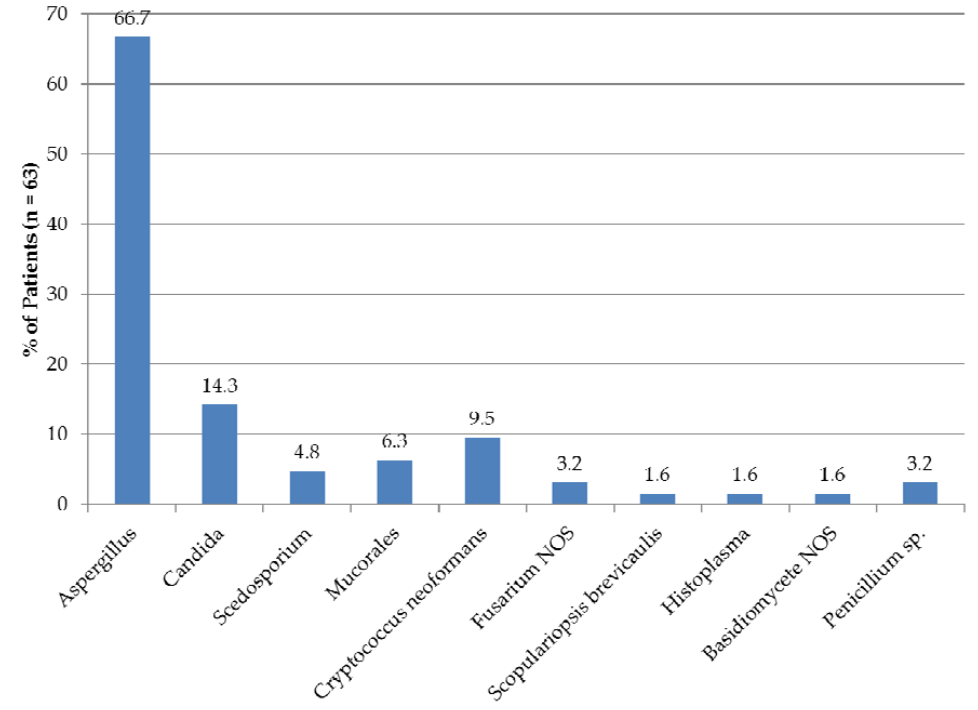
Figure 4. Fungal microorganisms, demonstrated by culture and/or PCR. Penicillium spp. and the basidiomycete NOS were not regarded as the causative microorganism in the patients involved. NOS, not otherwise specified.